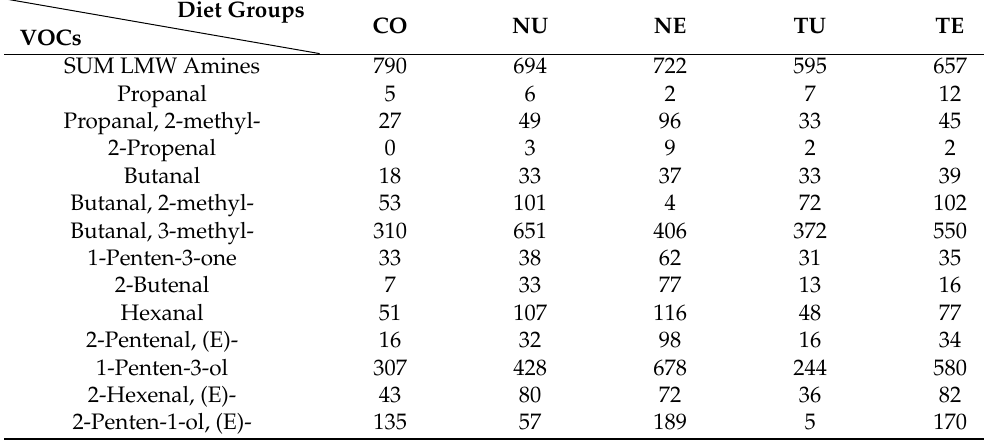
Table 1. Volatile oxidation products (ng/g) in feeds.